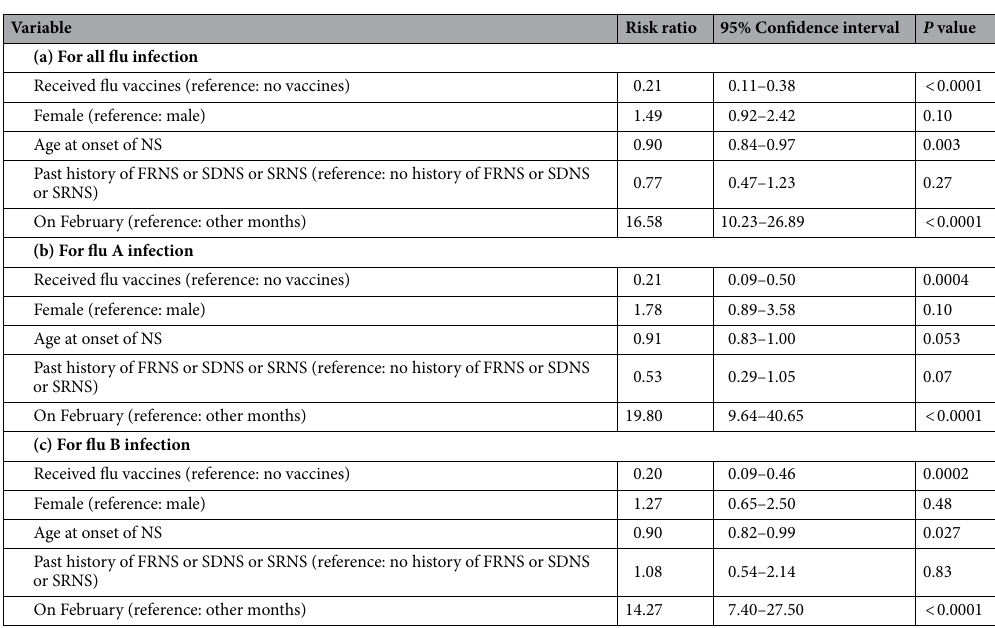
Table 3. Risk ratio for flu infectionin 306 children who received and did not receive flu vaccination (multivariate analysis). (a) all influenza infections, (b) influenzaA infections, (c) influenzaB infections. NS; nephrotic syndrome, Flu; influenza virus, FRNS; frequently relapsing NS, SDNS; steroid-dependent NS, SRNS; steroid-resistant NS.